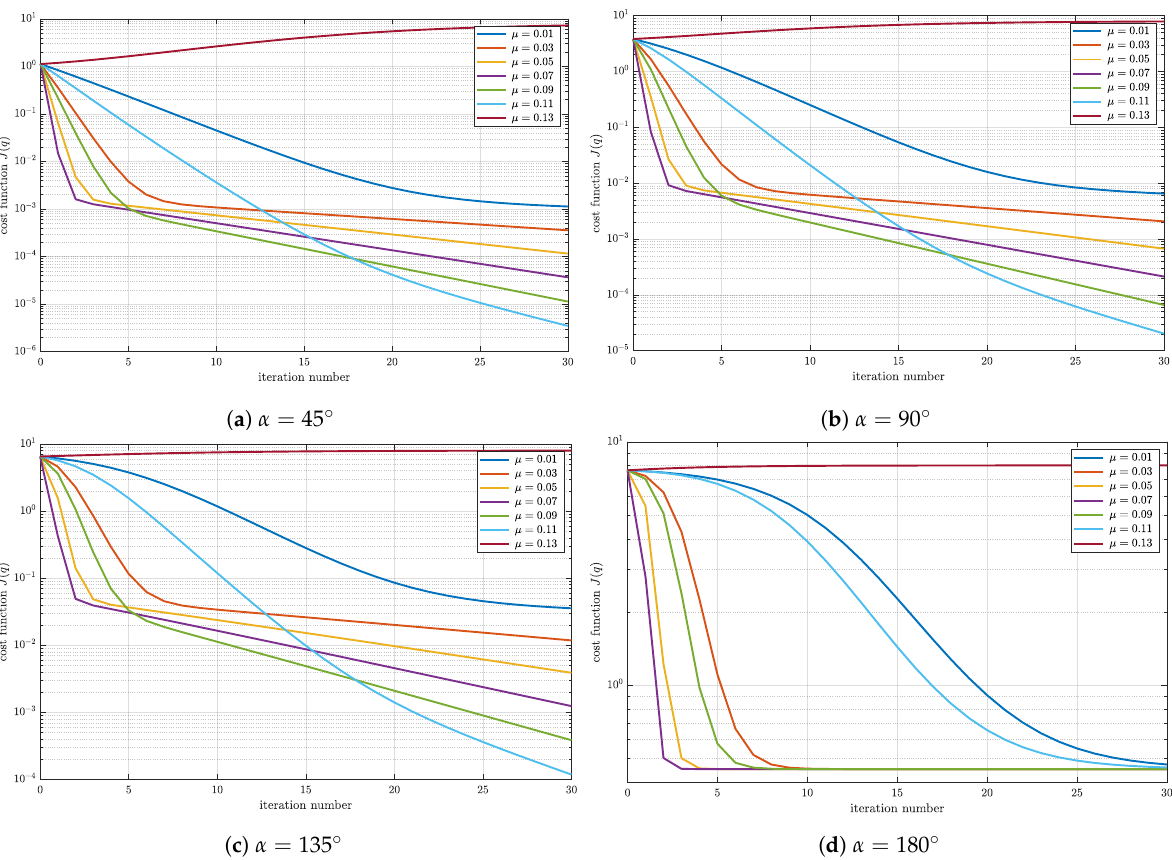
Figure 2. Cost function J ( q ) of each iteration for different step size µ and angle of rotation α